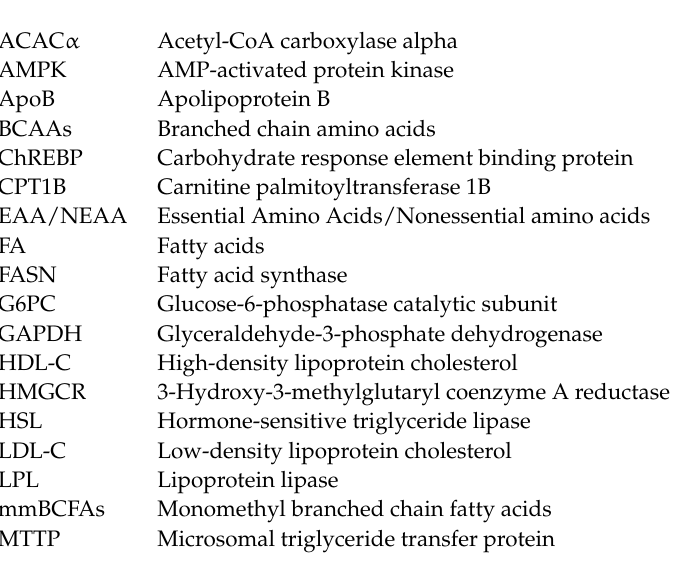
Table S1: Primers used in Supplemental Figure S1 for real-time